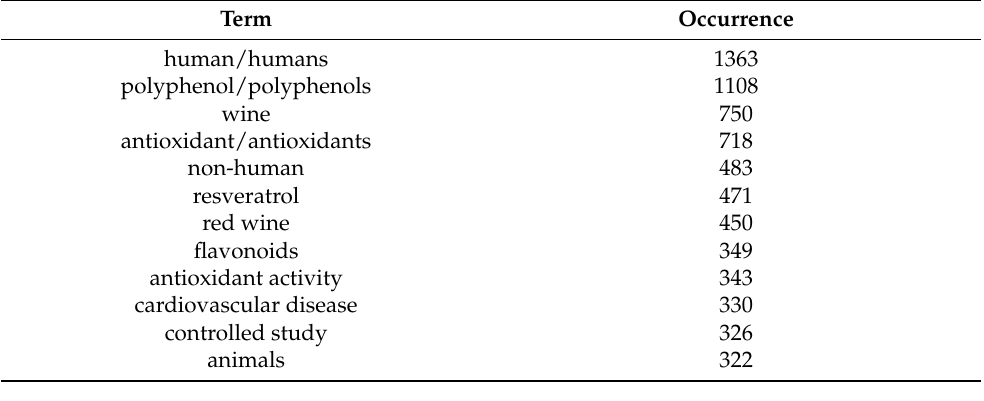
Table 1. The top-recurring terms on the relationships between wine polyphenol and health research. (Bibliometric data were extracted from the Scopus online database and elaborated by VOSviewer software).